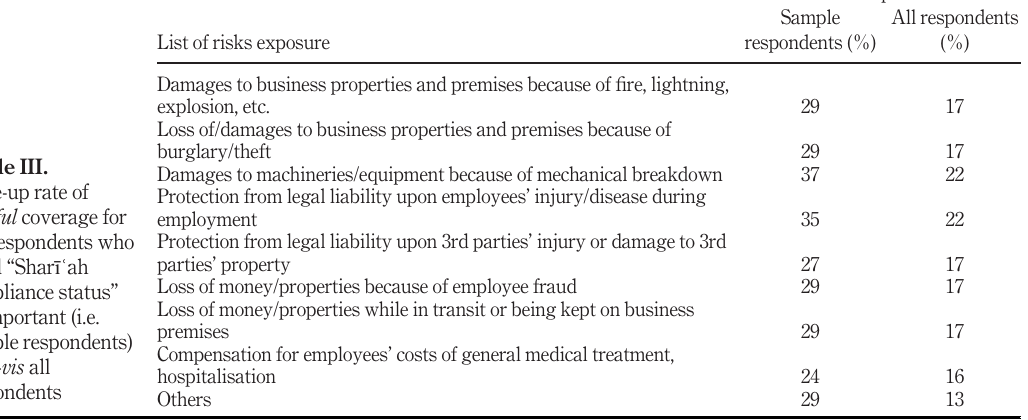
Figure 14. Ranking of factors considered by respondents whether to obtain tak (cid:1) aful or insurance coverage